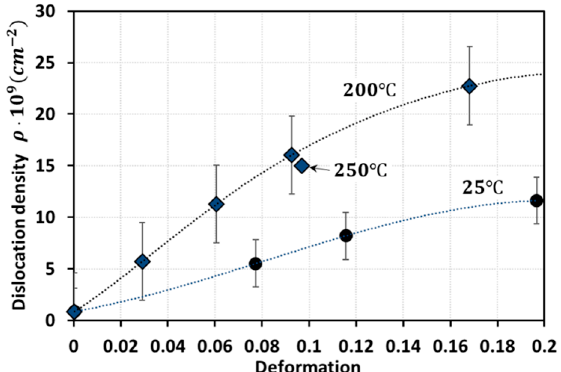
Figure 2. Dislocation density versus deformation graphs at different strain and temperature levels [12,13].